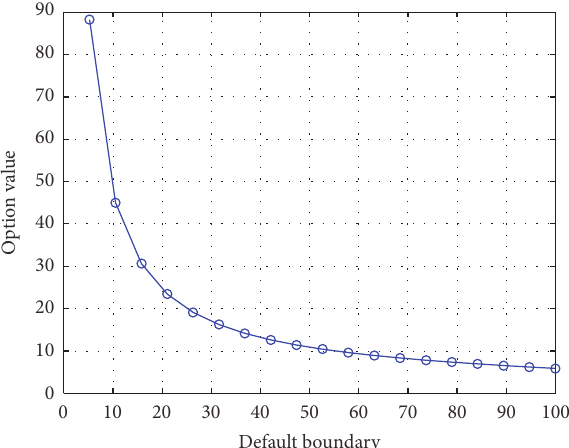
Figure 5: Option value with different default boundary.